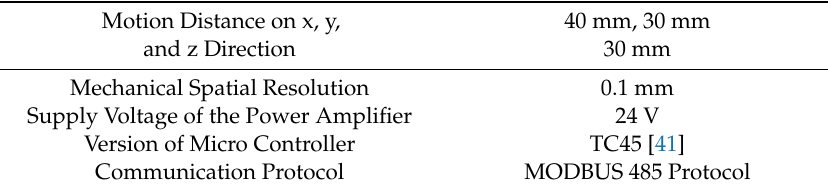
Figure 7. Block diagram of the measurement system. Table 2. Main parameters of the measurement system.